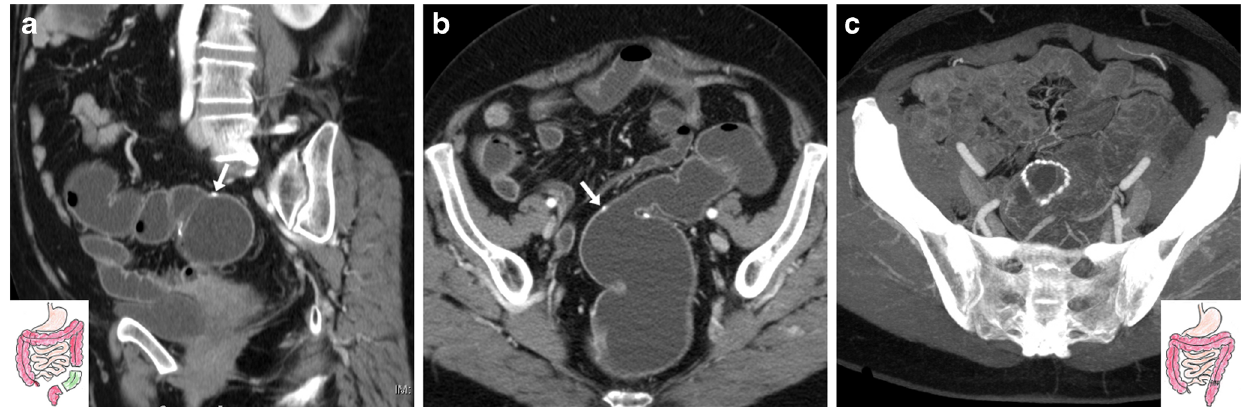
Fig. 2 Expected status after elective sigmoid colon resection for diverticular disease with primary anastomosis (surgical scheme shown in insets) in a 60-year-old female. WE-MDCT ( a , b ) showed good